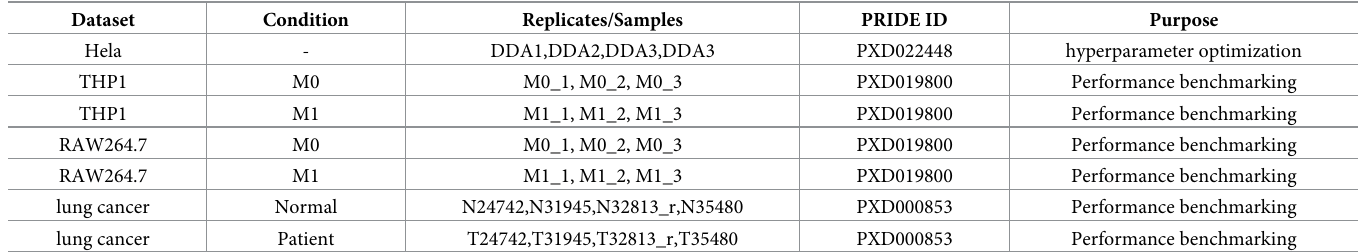
Table 1. Summary of datasets used for hyperparameter optimization and performance evaluation.